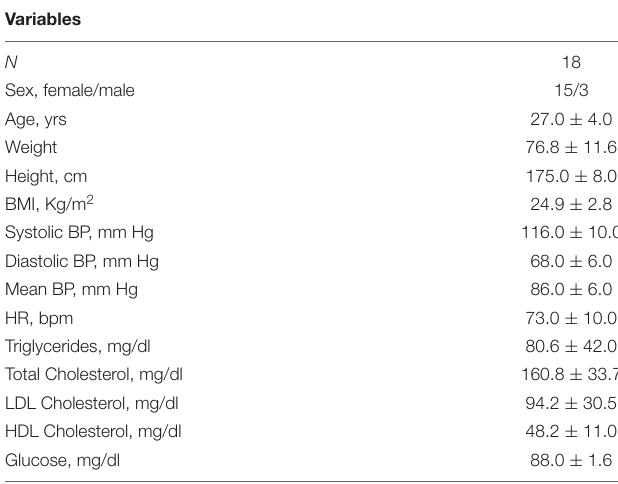
TABLE 1 | Baseline characteristics.